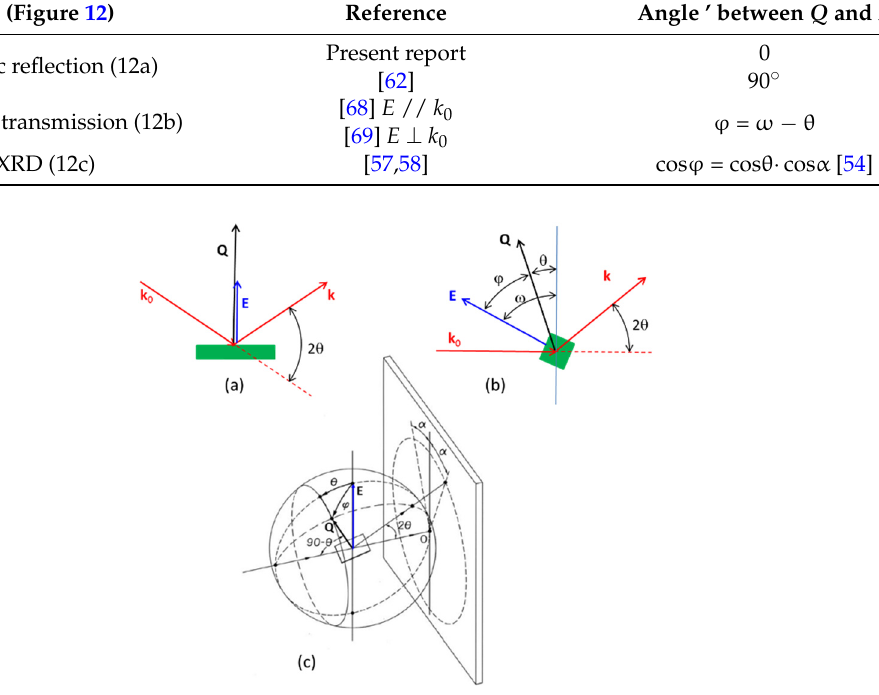
Figure 12. Experimental arrangements for diffraction measurements under electric fields.